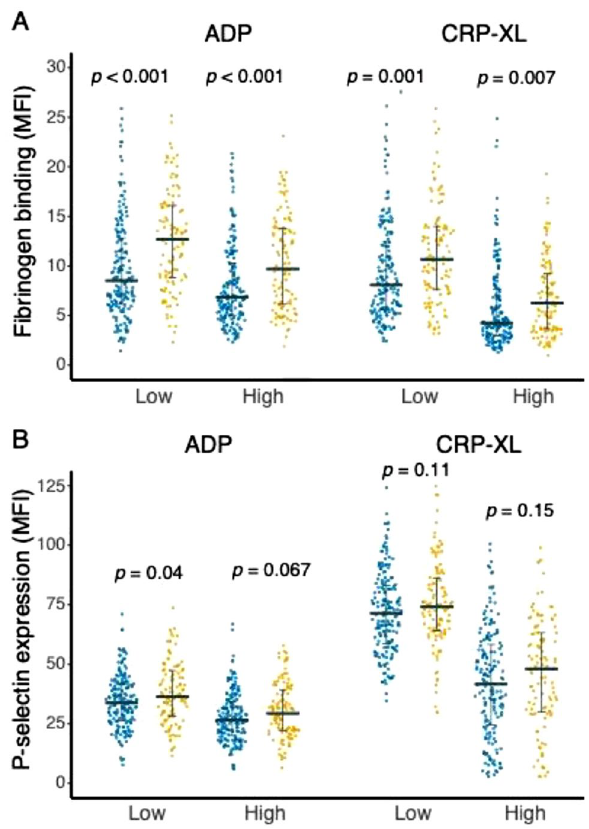
Figure 4. Platelet reactivity after collagen (CRP-XL) and ADP stimulation. ( A ) Platelet fibrinogen binding is depicted as mean fluorescence intensity (MFI) after ex vivo stimulation with platelet agonist collagen-related peptide (CRP-XL; 33 ng/mL; 625 ng/mL) and adenosine diphosphate (ADP; 1.2 μM, 125 μM). ( B ) Platelet degranulation measured by P-selectin expression is depicted as mean fluorescence intensity (MFI) after ex vivo stimulation with CRP-XL (33 ng/mL; 625 ng/mL) and ADP (1.2 μM, 125 μM). Data are shown as dotplot with error bars median and interquartile range (IQR). Data were analyzed using unpaired Student’s T-test. People living with HIV (PLHIV); healthy controls